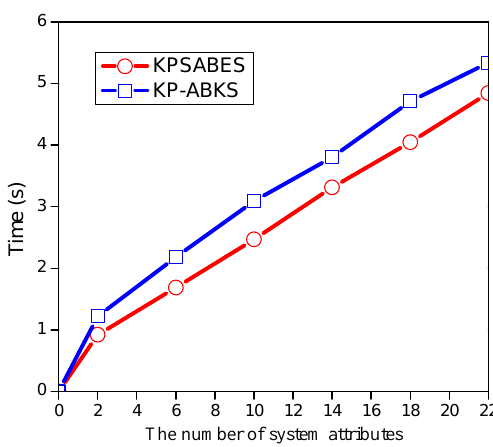
Figure 3. The time cost of Setup algorithm in KPSABES and KP-ABKS.